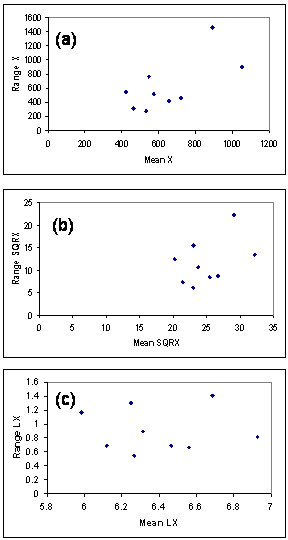
Mean-Range Plot for Pertussis (1953–1962). (a) Mean and range for non-transformed data (X). (b) Mean and range applying the square root transformation (SRX). (c) Mean and range applying the logarithmic transformation (LX).